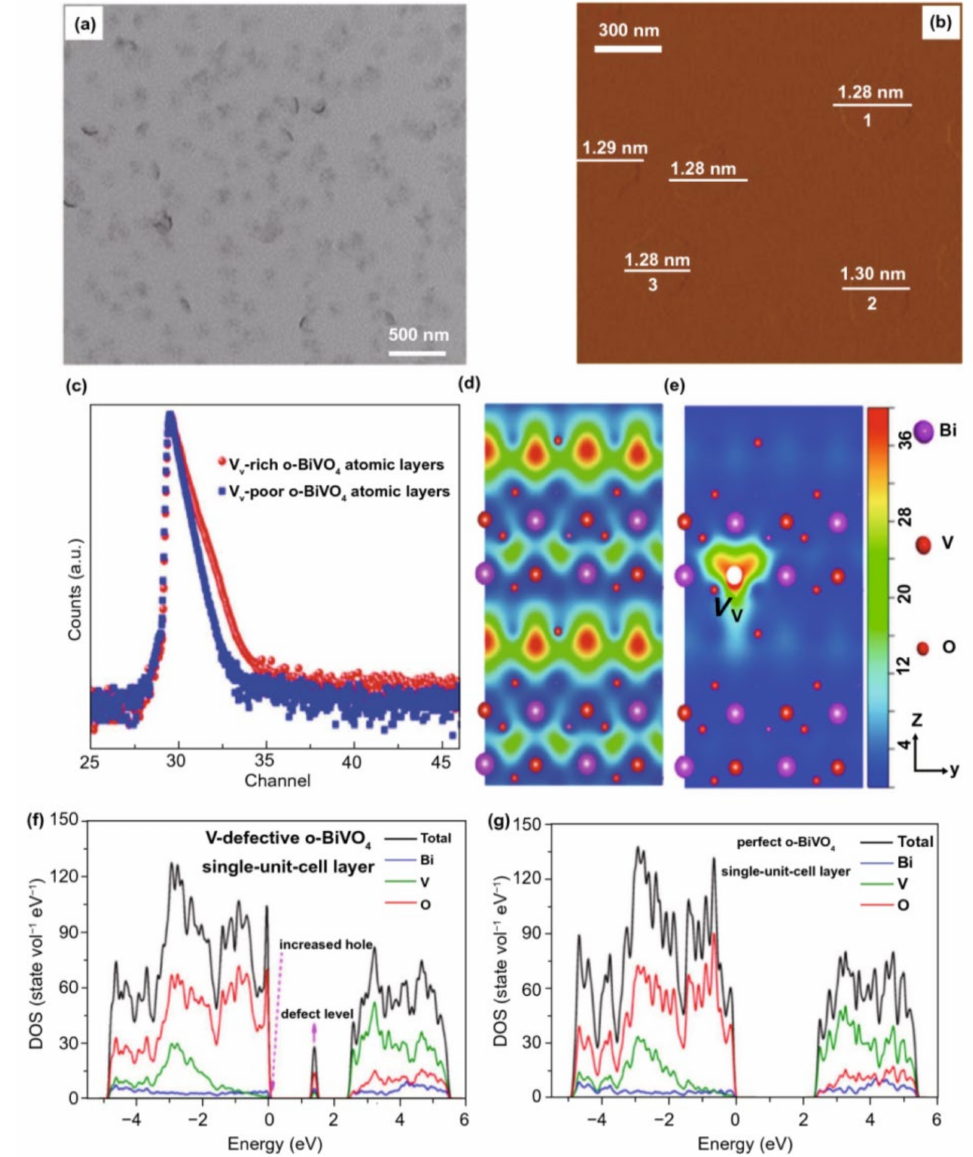
Figure 3. ( a , b ) TEM and AFM photographs of V v -rich o-BiVO 4 ; ( c – e ) defects study of Vv-rich and Vv-poor o-BiVO 4 atomic layers; ( c ) duration spectra of positron; ( d , e ) schematic for entrapped positrons; ( f ) Vv defects in the single unit cell layer slab of o-BiVO 4 and slab of pure o-BiVO 4 single unit cell estimated by DOSs, ( g ) along [001] direction. Adapted from [60] Copyright 2017, American Chemical